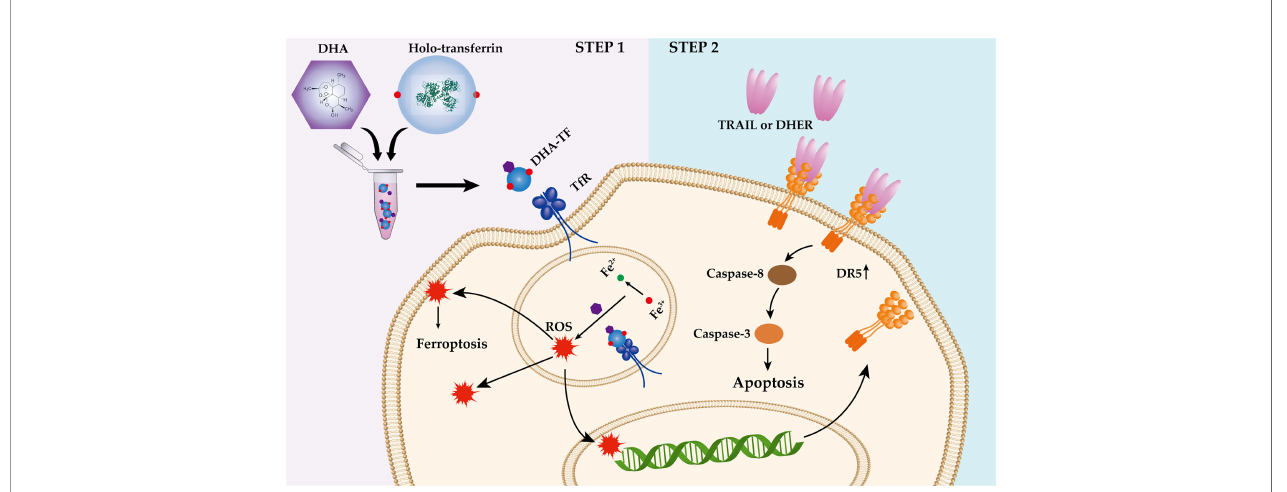
FIGURE 9 | Schematic illustration of the DHA-TF with DHER treatment in TNBC